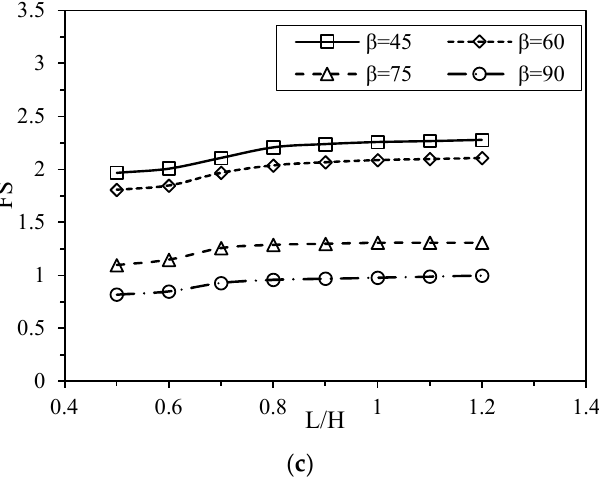
Figure 7. Effect of nail length on stability of slopes with different backslope inclinations: ( a ) α = 0°, ( b ) α = 10°, and ( c ) α = 20°.